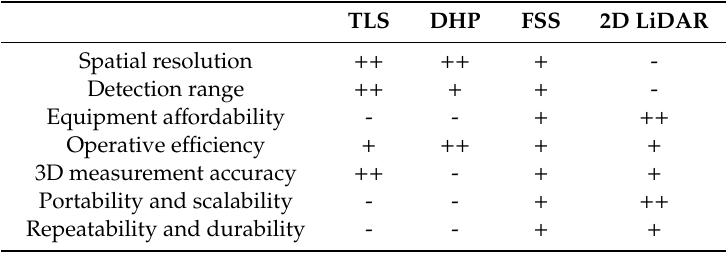
Table 1. Qualitative ranking of advantages among terrestrial laser scanning (TLS), digital hemispherical photography (DHP), fusion scanning system (FSS), and sweeping 2D LiDAR for canopy sampling. Ranks are denoted as ++, + and – in descending order.